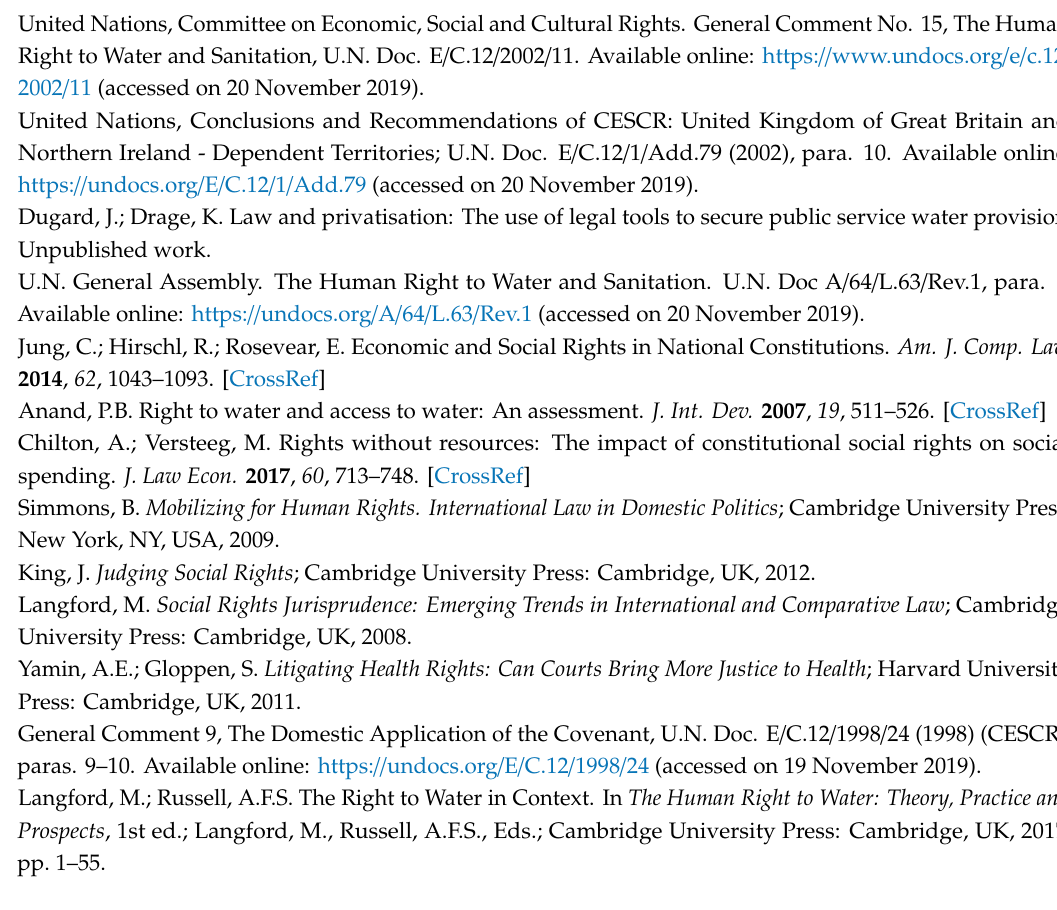
Table S1: ESCRs & Basic Water Access, Autocracies only, 2000-2015, Table S2: ESCRs & Basic Water Access, Democracies only, 2000-2015, Table S3: Democratic Governance, Right to Water, & Basic Water Access, 2000-2015, Alternate Right to Water Variable, Table S4: Naive models with categorical independent variable, 2000-2015, Table S5: Rule of Law and ESCRs, 2000-2015, Categorical Variables, Table S6: Civil Society Participation and ESCRs, 2000-2015, Categorical Variables, Table S7: High Court Independence and ESCRs, 2000-2015, Categorical Variables, Table S8: Economic and Social Rights & Basic Water Access, 2000-2015, w / Population Density, Table S9: Democratic Governance & Basic Water Access, 2000-2015, w / Population Density, Table S10: Civil Society Participation & Basic Water Access, 2000-2015, w / Population Density, Table S11: High Court Independence & Basic Water Access, Constitutionalization, Table S13: Civil Society & Basic Water Access, 2000-2015, Level of Constitutionalization, Table S14: High Court Independence & Basic Water Access, 2000-2015, Level of